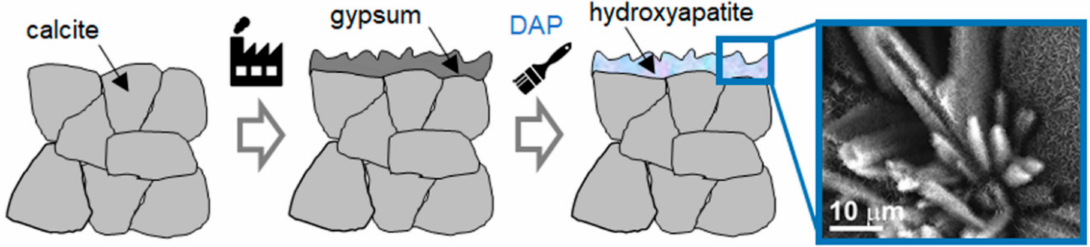
Figure 13. Scheme illustrating the de-sulphating action expected from the phosphate